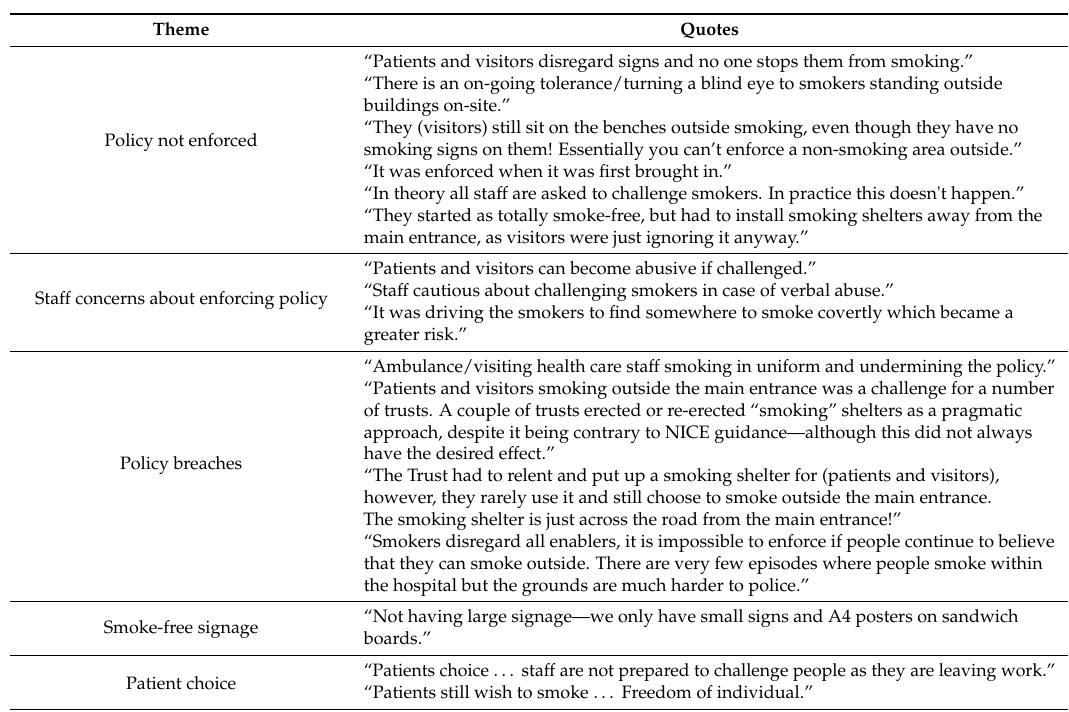
Table 3. Barriers to achieving the smoke-free